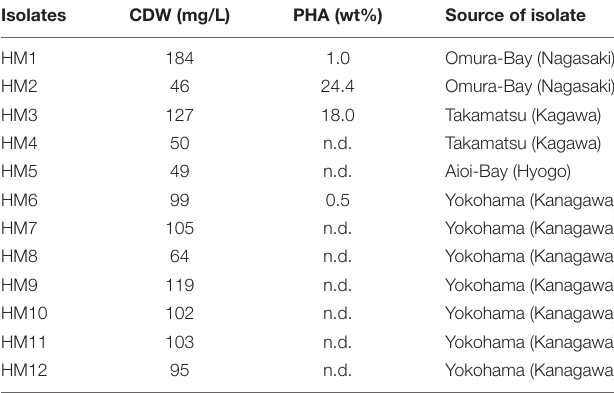
TABLE 1 | PHA content (wt%) of isolates.